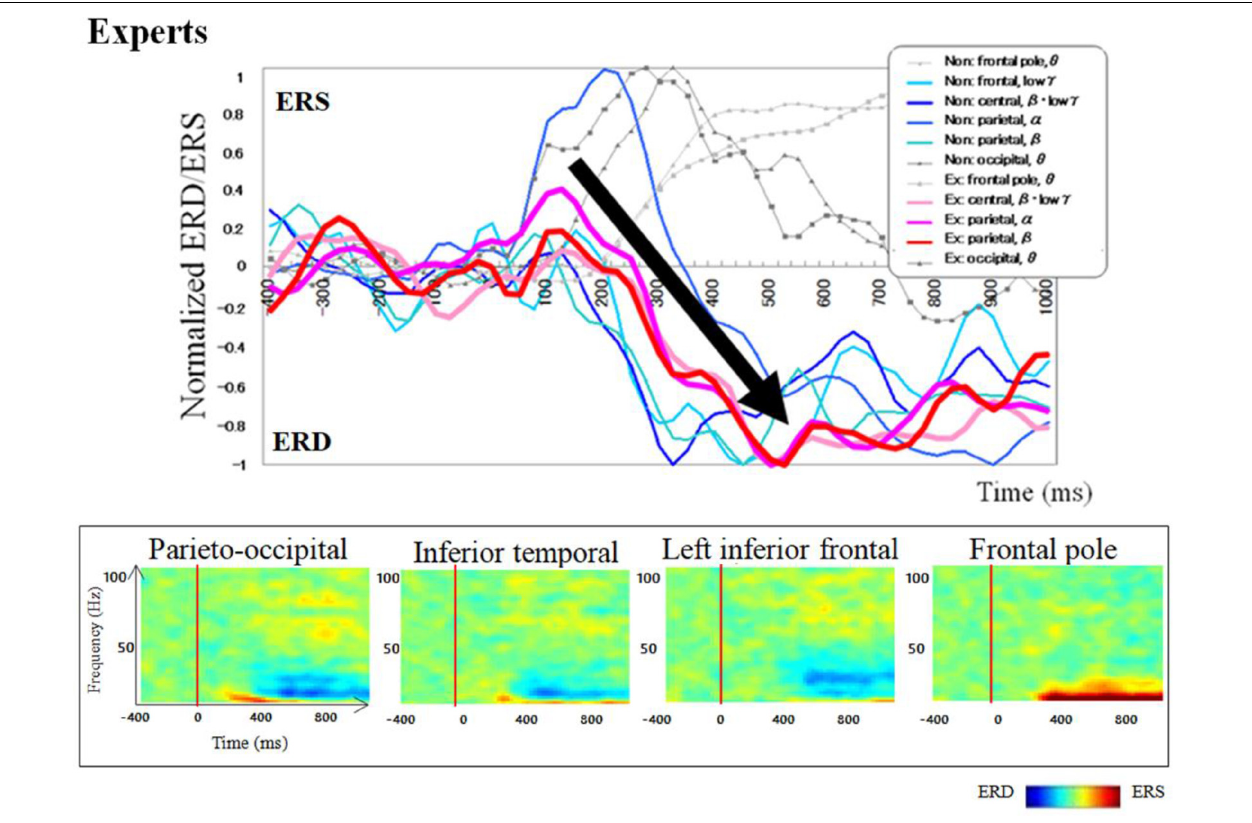
FIGURE 8 | A group average of a time-frequency profile of oscillatory changes for Abacus experts during mental addition experiment. The upper graph shows the time course of the normalized oscillatory changes in the frequency bands specific to the detected areas and lower graphs show time-frequency spectrograms in each area. The time window is between − 400 and 1000 ms; the movement onset is at 0 ms, and the frequency interval ranges from 4 Hz to 100 Hz. The red areas in the time-frequency maps indicate increases in power (ERS), and the blue areas indicate decreases in power (ERD). In the figure legend, “Non.” means non-abacus experts and “Ex.” means abacus